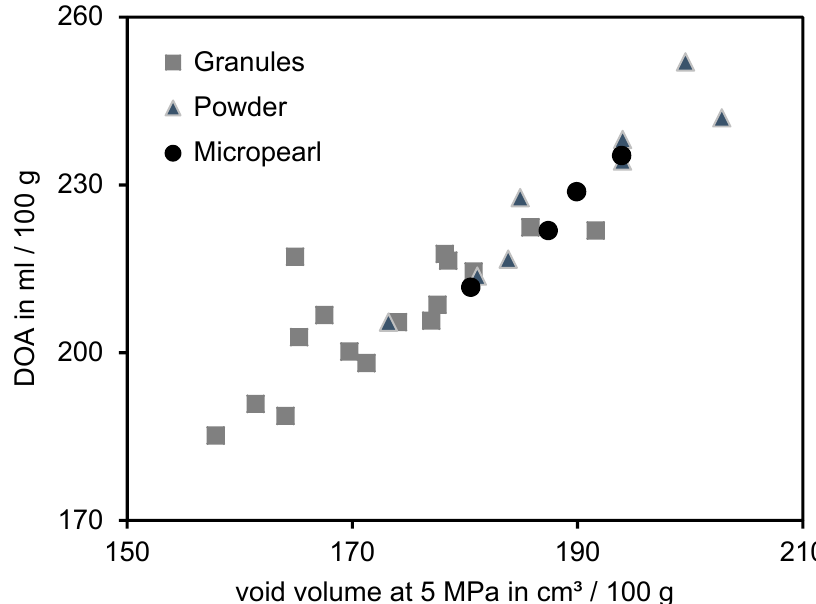
Figure 5. Correlation between void volume at 5 MPa and DOA measurement.